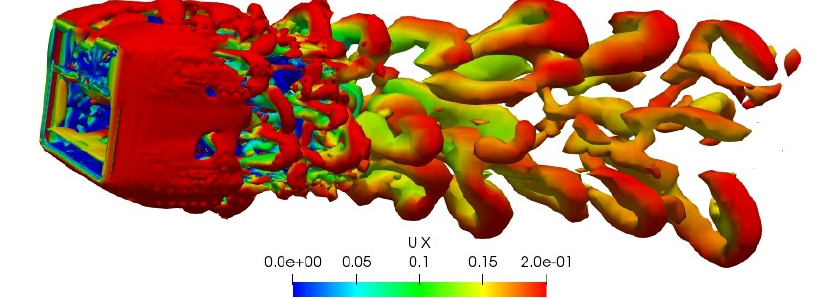
Figure 9. The isosurfaces vorticites structures coloured with stream-wise